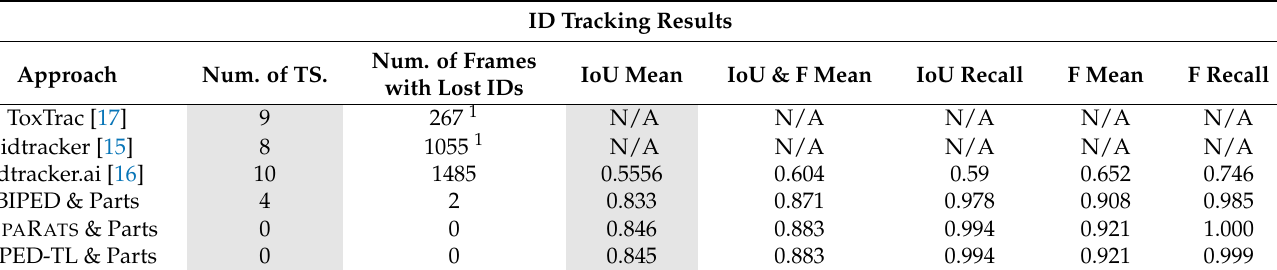
Table 1. Comparison of segmentation-based trajectory tracking of methods which do not require prior data annotation, on our test data of 3600 frames. TS denotes the track switches metric from [9], which measures the number of ID switches during tracking. Lost ID: there are less than two different foreground labels in the frame. For ToxTrac and idtracker, per frame segmentation masks are not available. Superscript 1 marks that the result is computed by means of the GUIs of the cited method, the best we could do for comparisons. Gray highlight: Mean of the IoU values for all frames. For benchmark measures, we used the same ones as in RATS [9]. ID Tracking